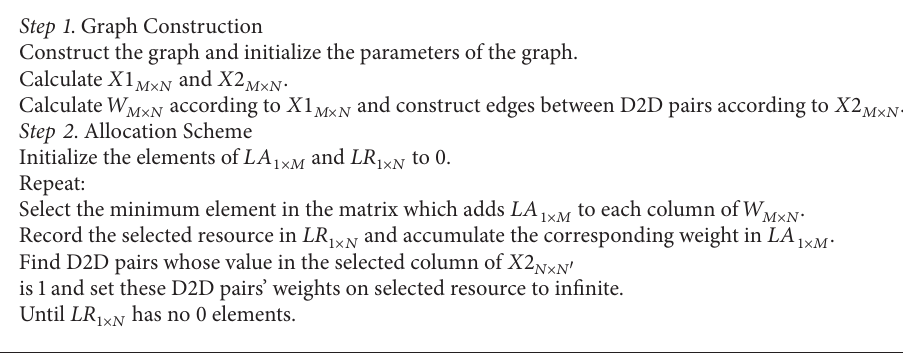
Algorithm 1: Graph-based resources allocation algorithm.